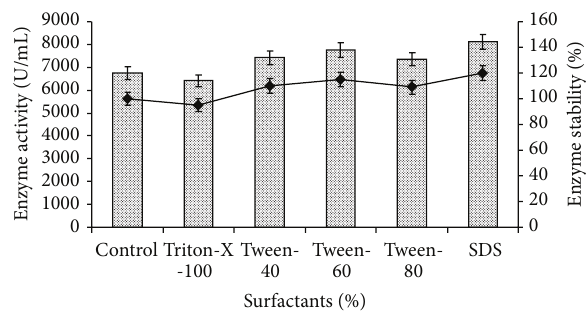
Figure 12: Effect of different surfactants on amylase production and stability.Thecontrolflaskdoesnotcontainanysurfactant.Testflasks contained different surfactant in the medium at a level of 1.0% (w/v). The flasks were inoculated with culture and were incubated at initial pH 7.0, 55 ∘ C for 24h. For enzyme activity, the reaction was assayed and for stability enzyme was preincubated with different surfactants (1.0%) at 55 ∘ C for 1h and assayed by standard assay method. Error bars presented mean values of ± standard deviation of triplicates of three independent experiments.